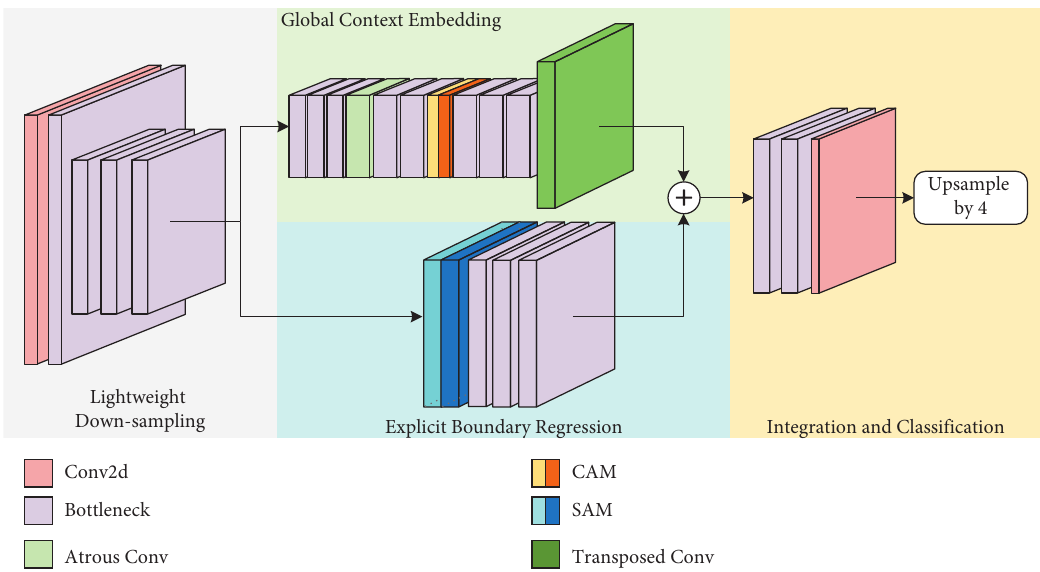
Figure 3: The two branches’ architecture of proposed method and detailed structure diagram of bottleneck, CAM, and SAM are given afterwards. The symbol “ ⊕ ” represents elementwise summation (best viewed in color).